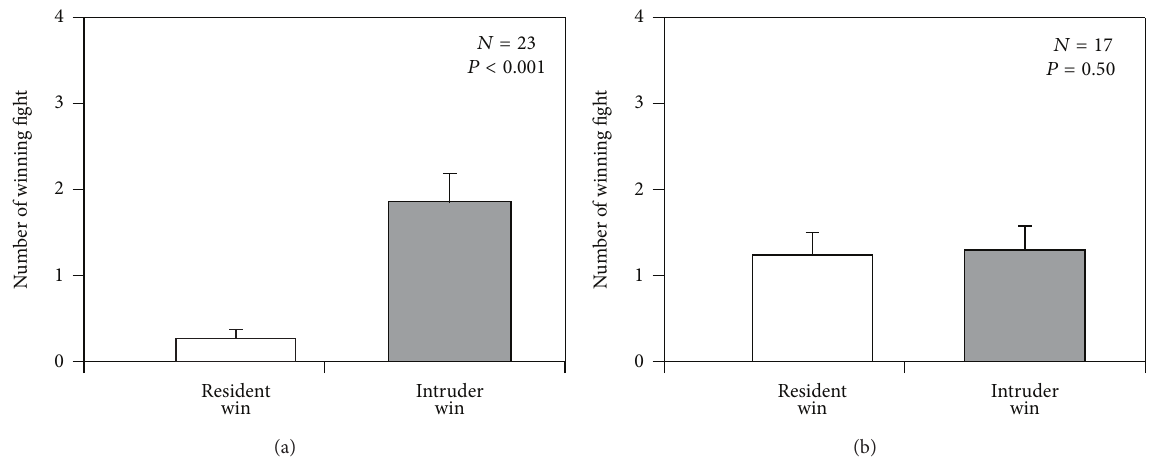
Figure 1: The times individuals took in winning fights in the control contest (experiment 1). (a) A larger intruder was introduced. (b) A similar-sized intruder was introduced. The data are means ± standard error